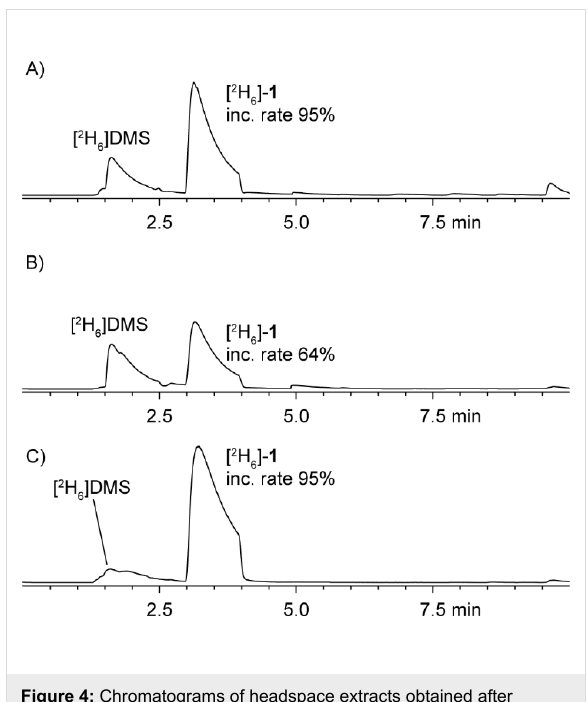
Figure 4: Chromatograms of headspace extracts obtained after feeding of [ 2 H 6 ]DMSP by the use of SPME from (A) R. pomeroyi DSS-3 wild type, (B) R. pomeroyi DSS-3 dmdA − , and (C) R. pomeroyi DSS-3 dddQ − . Trace amounts of [ 2 H 6 ]- 2 and [ 2 H 6 ]- 3 were also found (not